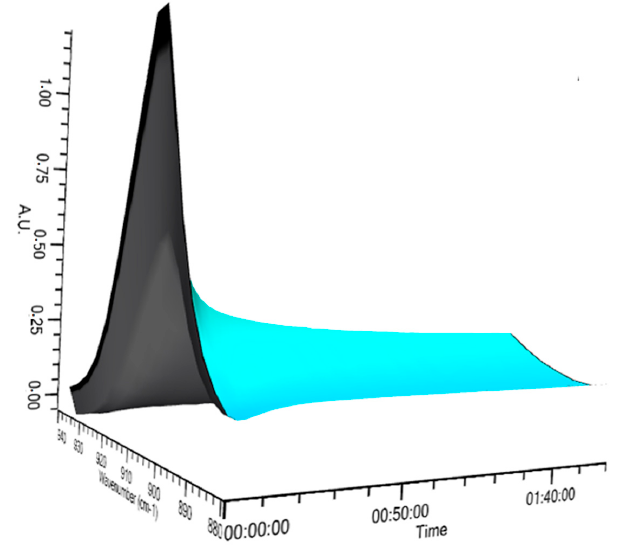
Figure 2. Analysis of real-time FTIR measurements showing changes in the intensity of the band at ˜ υ = 904 cm − 1 with time during the hydrosilylation of 5-(allyloxy)-1,1,2,2,3,3,4,4-octafluoropentane in the presence of Karstedt’s catalyst. Molecules 2020 , 25 , x